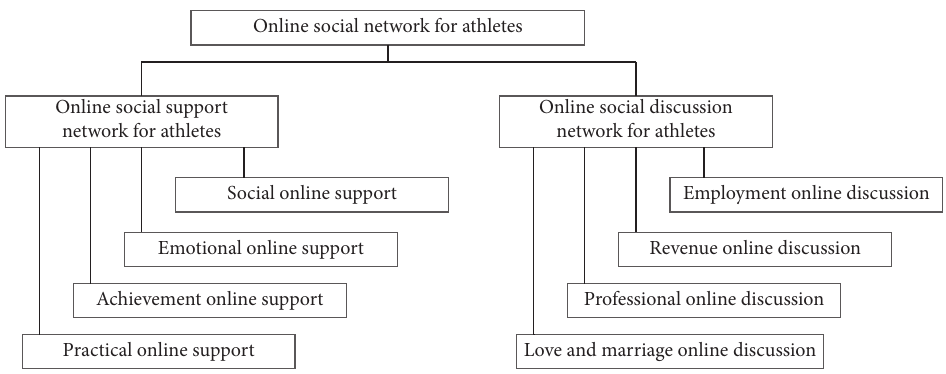
Figure 1: Organization structure of social network of